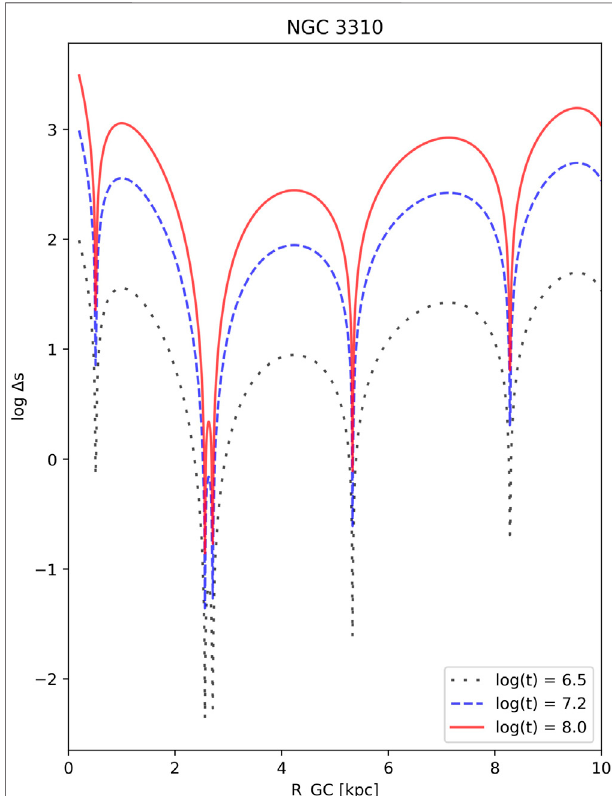
FIGURE 4 | The orbital drift of the open cluster in NGC 3310 from their host spiral arm asafunctionofthe galacto-centricradiusand time.The values of Δ s under the logarithm are in parsec. Used parameters: Ω p (cid:1) 14 km/s/kpc, Δ R (cid:1) 0 . 1 kpc,rotationcurvefromEpinatetal.(2008),approximatedbya high-degree polynomial (deg >